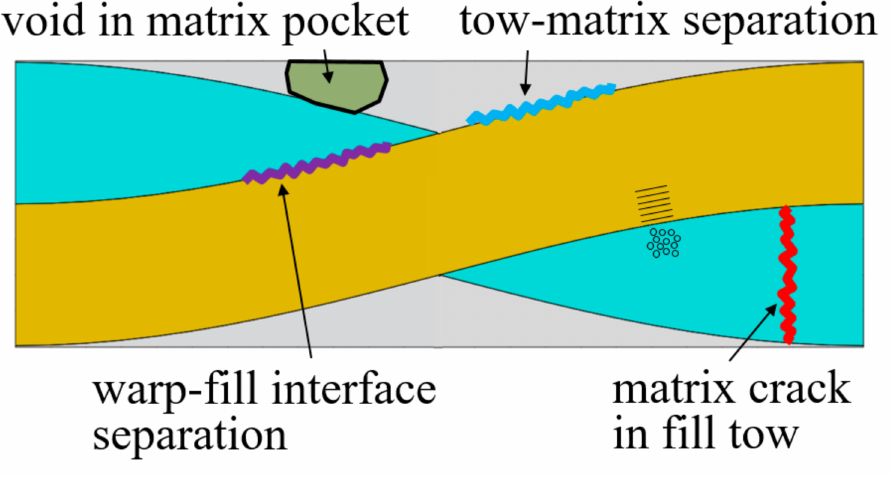
Figure 15. Types of defects in plain weave textile